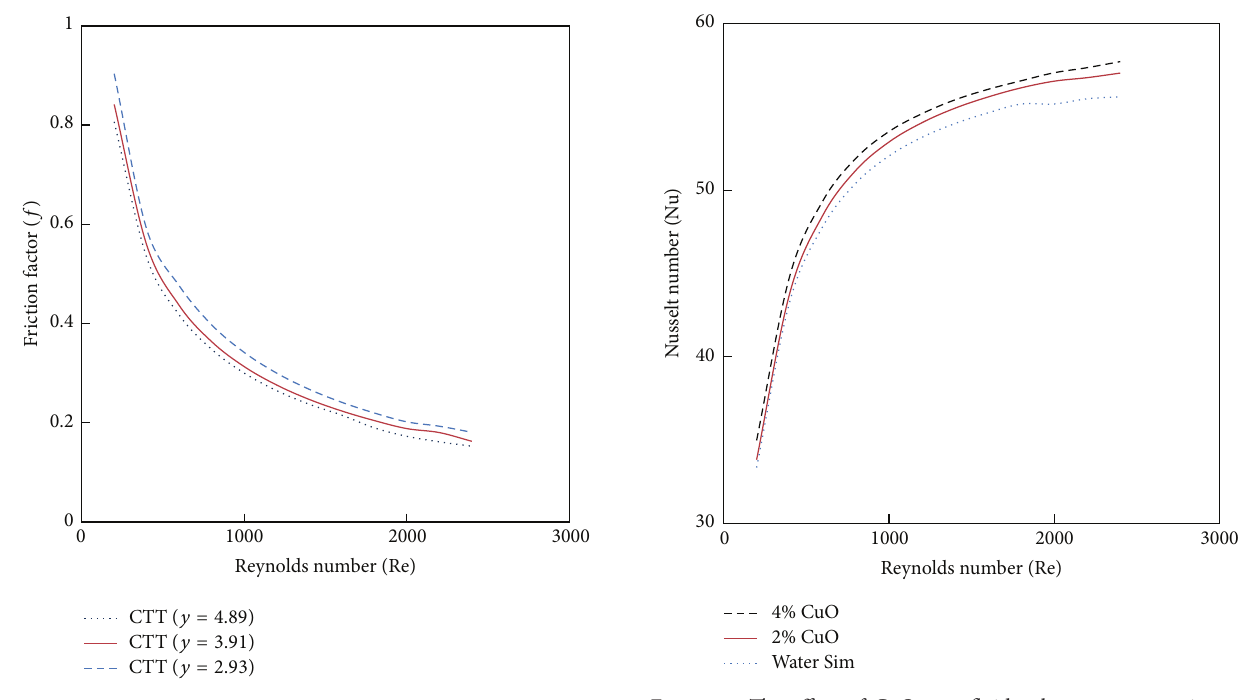
Figure 6: The effect of twist ratio ( y ) on friction factor.